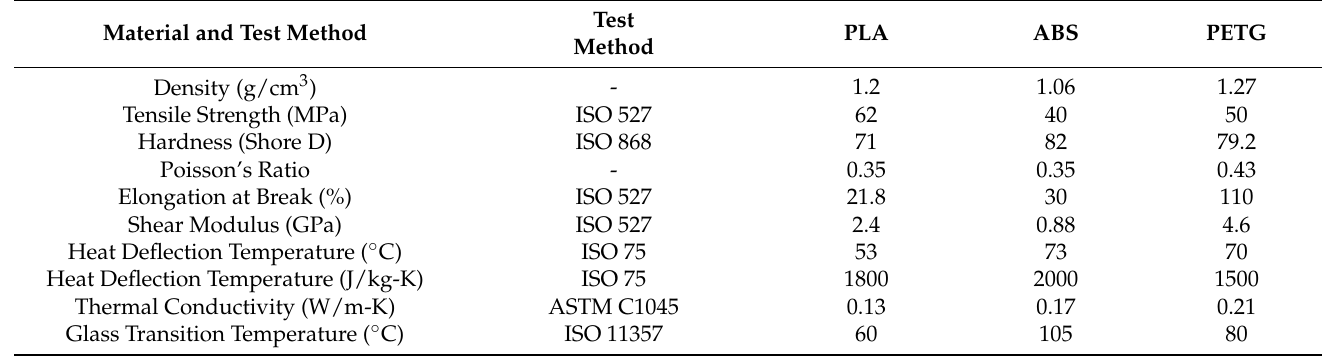
Table 1. Properties of polymeric materials.